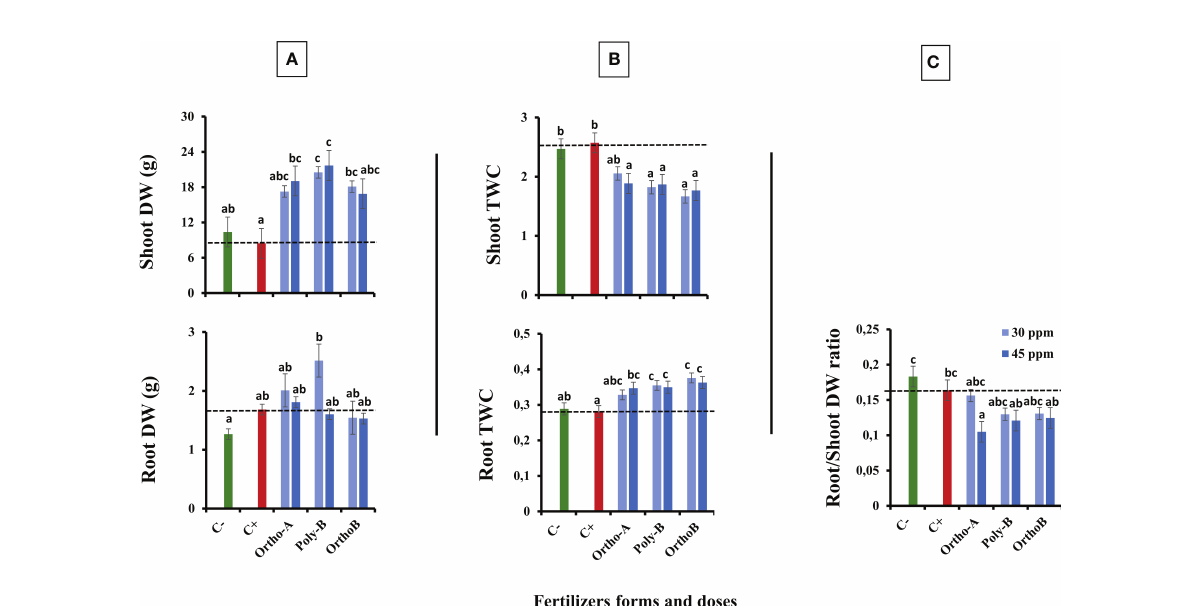
FIGURE 4 The combined effect of P-fertilizer forms (Ortho-A, Poly-B and Ortho-B) and doses (0, 30 and 45 ppm) on Shoot and Root dry weight (DW) (A) , Shoot and Root Tissue water content (TWC) (B) and Root/Shoot DW ratio (C) of wheat plants grown under salt stress conditions, measured at 12 WAS. C-: unfertilized plants without salt application, C+ salt-stressed and unfertilized plants. Statistical analysis was performed using one-way ANOVA and SPSS data processing software. GT2 of the Hochberg test was used for the comparison of means. Treatments having the same letters are not signi fi cantly different at the 5%